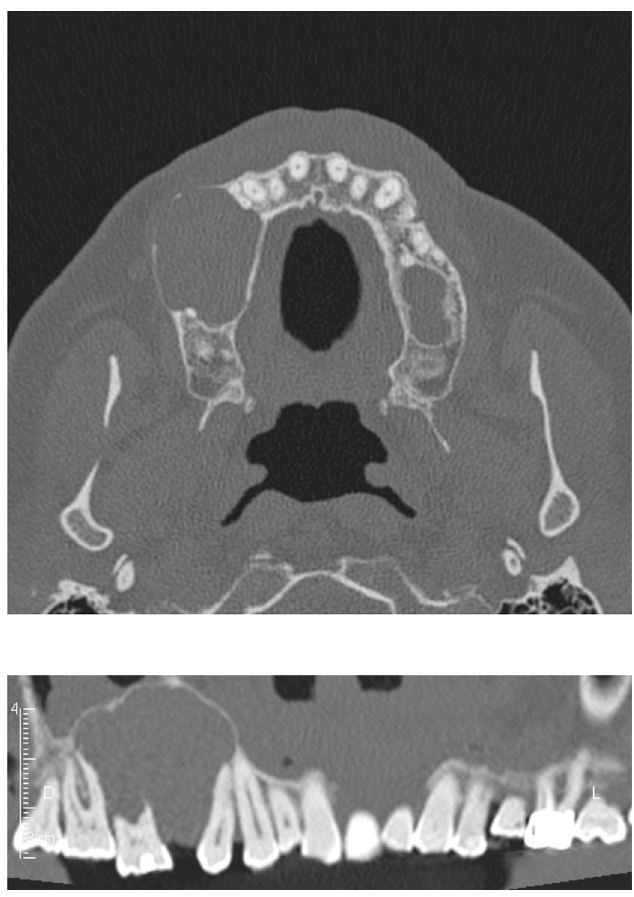
Fig. 2. Cone-Beam CT analysis: maxillary osteolytic lesion of 4 cm in long axis.* Correspondence: